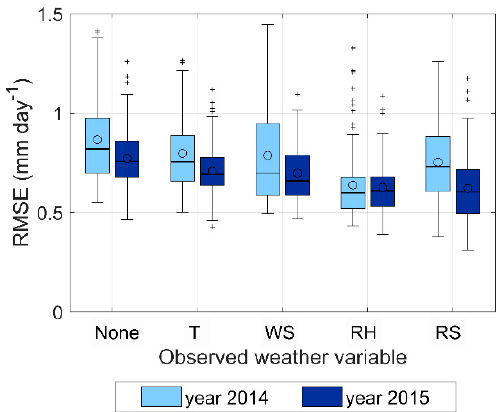
Figure 3. Root mean squared error (RMSE) of forecasted daily weather variables at the 18 automatic weather stations (AWS) sites for lead times from 1 to 5 days in the period: ( a ) June–September 2014; ( b ) June–September 2015.